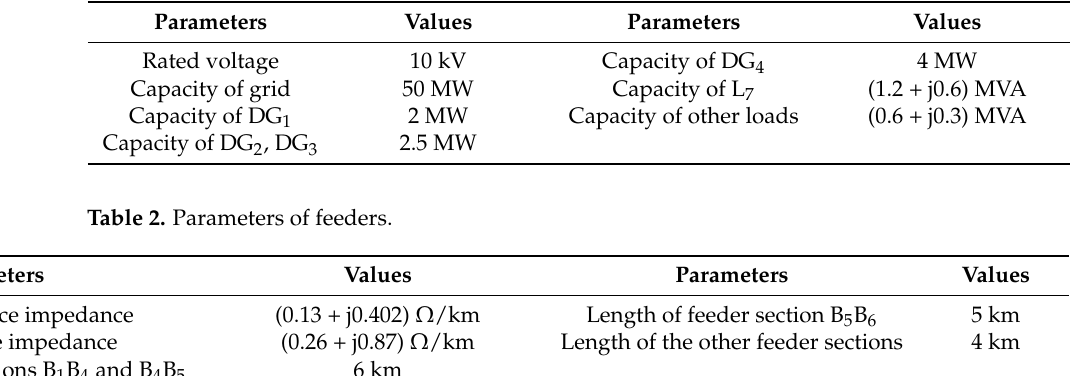
Table 1. Parameters of the system model.